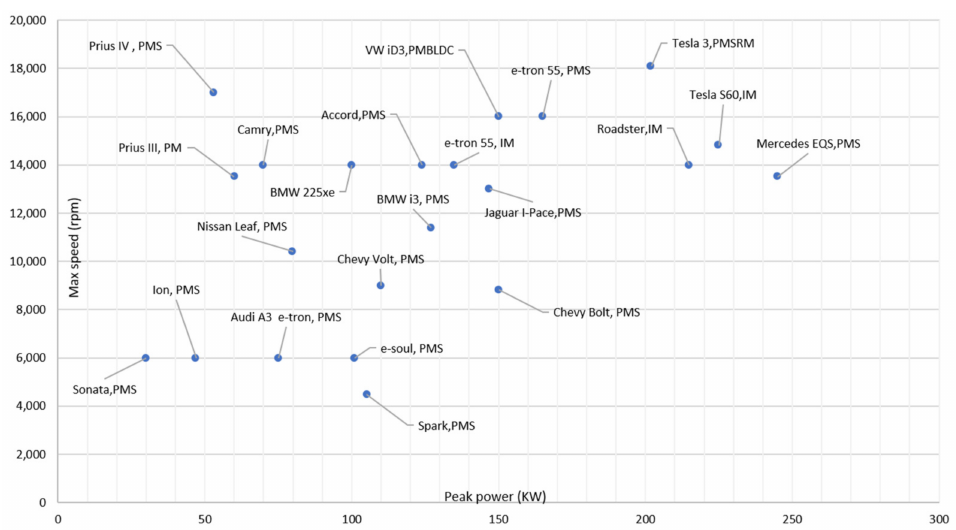
Figure 13. Maximum speed over peak power overview for the investigated motors